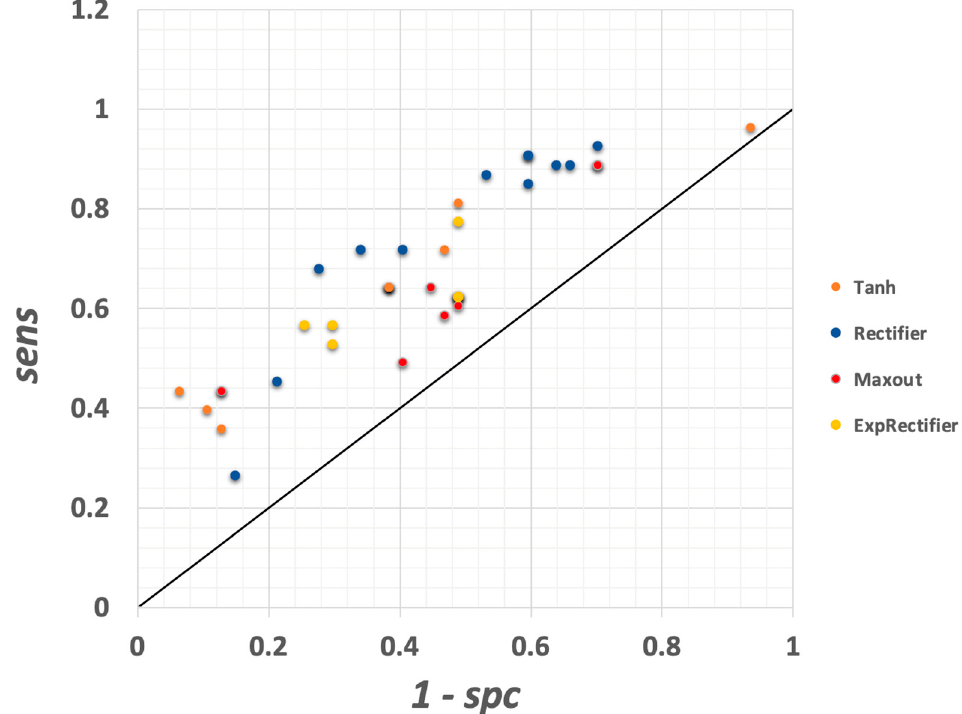
Figure 6. ROC curve for all deep learning models explored. Models differ by adjusting parameters within RapidMiner. See text for remaining parameters adjusted. Maximal performance for deep learning was sens = 0.68 and spc = 0.72, with J = 0.4 .